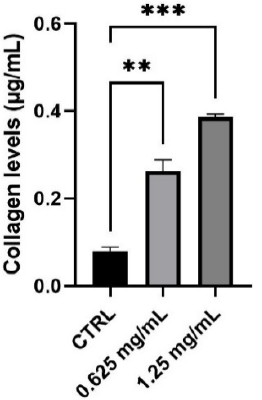
Figure 2. Representative images of immunofluorescence BrdU assay ( A ) DNA is marked in blue with Hoechst 33258 while BrdU is visible in green. ( B ) Quantitative assessment of BrdU positive cells expressed as a percentage (mean ± SD) compared to control after 24 h of treatment with the RETINOIDS SERUM (0.625 and 1.25 mg/mL). Values of * p < 0.05 were considered statistically significant compared to untreated cells (CTRL).